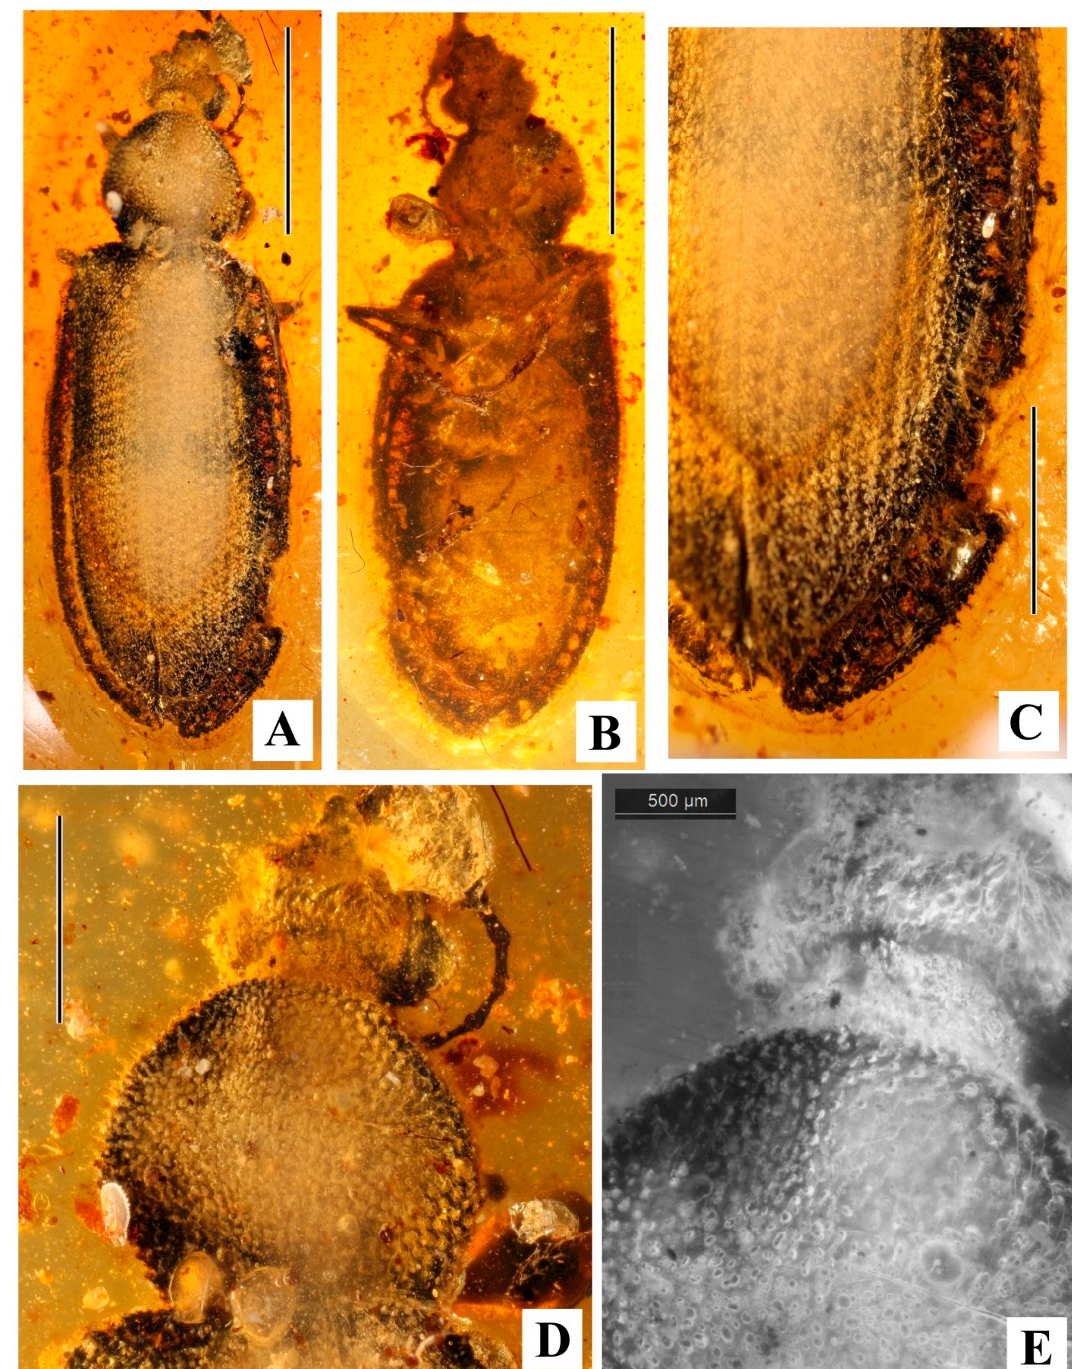
Figure 16. Ommatinae (Cupedidae): Polykius alberti sp. nov. , holotype ZIN Cuped 003 (Lower / Upper Cretaceous: Upper Albian / Lower Cenomanian; Myanmar, Kachin, Burmese amber): A —beetle, dorsal, B —same, ventral, C —right elytron, dorsal; D —anterior part of body, dorsal; E —base of head and apex of pronotum, dorsal (fluorescent microscopy with filter set N21); length of inclusion 6.2 mm, scale bar for A and B = 2.0 mm, scale bar for C = 1.0 mm, scale for D shown with mention of mm;